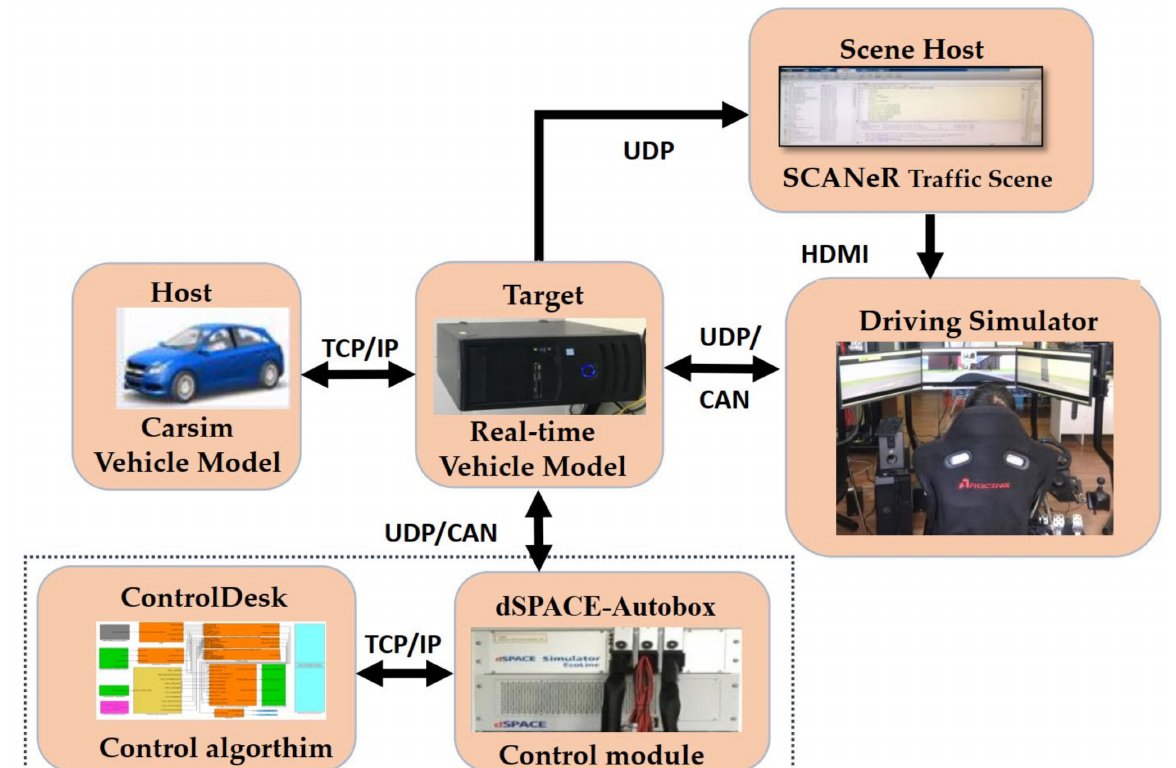
Figure 4. Structure of experimental